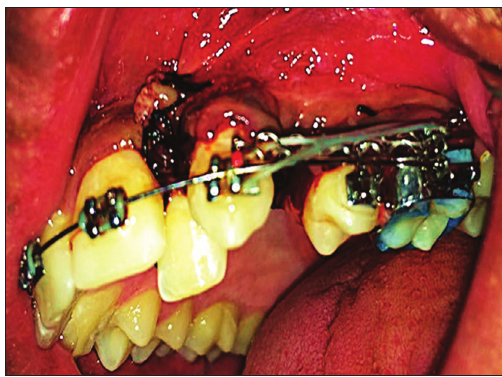
FIGURE 3. Retraction of the upper right canine using nickel–tita- nium spring and power chain.